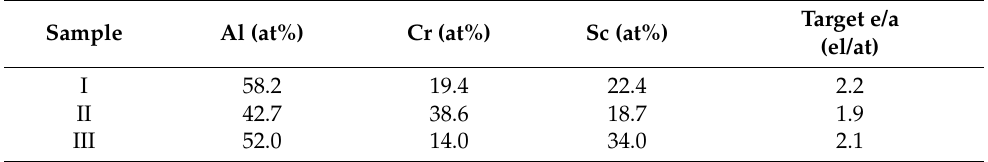
Table 1. Nominal compositions of the three samples. The target value of e/a is also given.